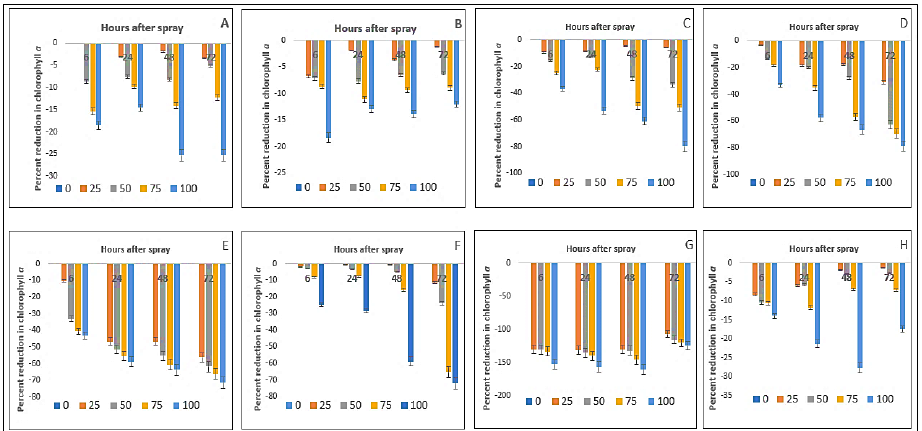
Figure 3. Reduction (%) of chlorophyll- a as a consequence of parthenium leaf methanol extracts on several crops and weeds: ( A )—Bambara groundnut; ( B )—Maize; ( C )— D. sanguinalis ; ( D )— E. indica ; ( E )— A. conyzoides ; ( F )— C. iria ; ( G )— E. hirta , and ( H )— C. difformis .